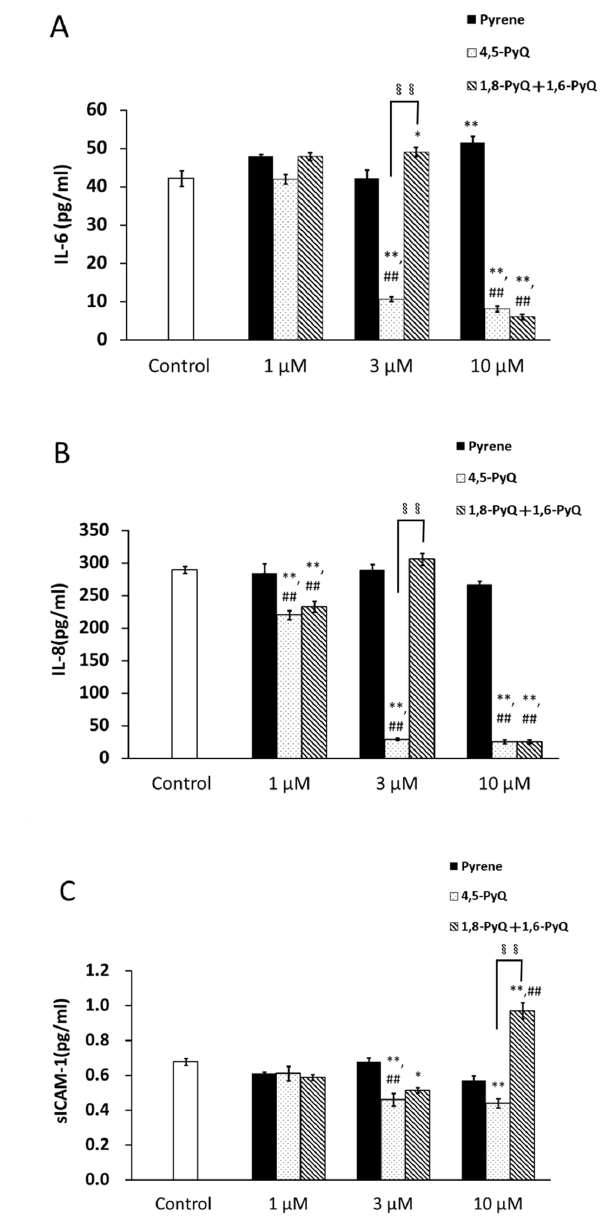
Figure 3. Effect of pyrene and its quinone forms on interleukin (IL) ‐ 6, IL ‐ 8, and soluble intercellular adhesion molecule (sICAM) ‐ 1 production from human bronchial epithelial cells. The protein levels of IL ‐ 6 ( A ), IL ‐ 8 ( B ), and sICAM ‐ 1 ( C ) in the culture supernatants, after exposure to pyrene and its quinone forms for 24 h, were measured using enzyme ‐ linked immunosorbent assay (ELISA). The data are expressed as the mean ± standard error of the mean (SEM) of four individual cultures. * p < 0.05, ** p < 0.01 vs. control, ## p < 0.01 vs. pyrene at the same concentration, §§ p < 0.01 vs. each other.